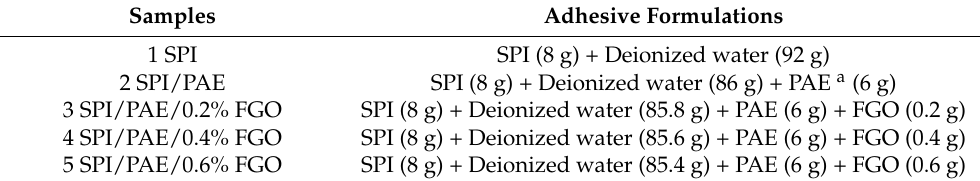
Table 1. Different adhesive formulations.